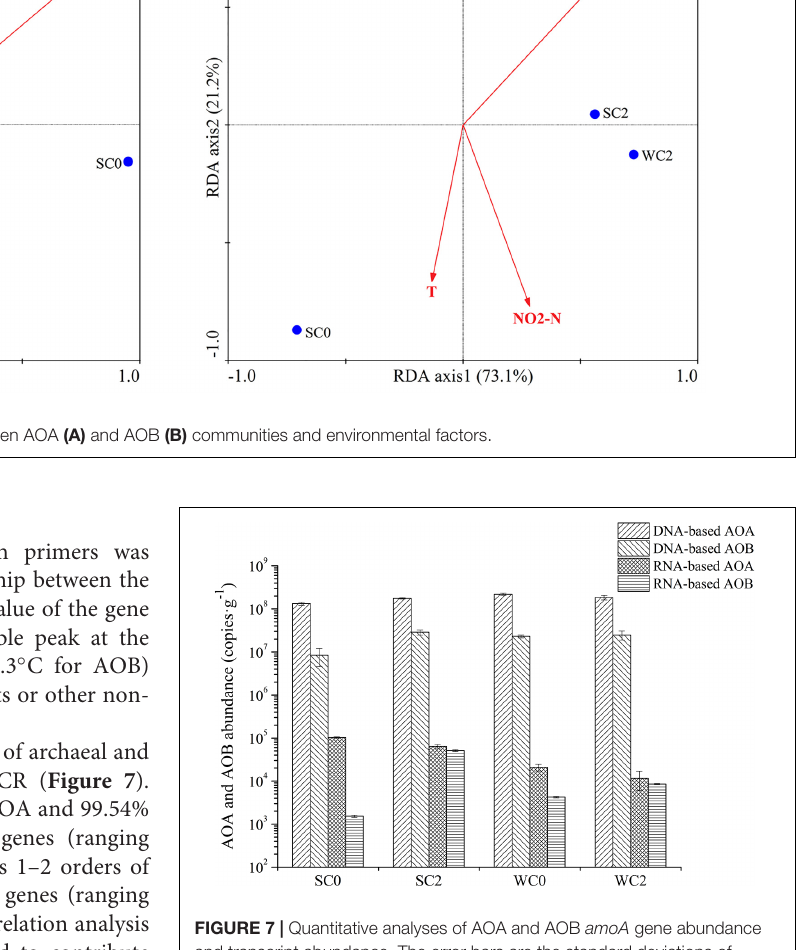
FIGURE 7 | Quantitative analyses of AOA and AOB amoA gene abundance and transcript abundance. The error bars are the standard deviations of triplicate